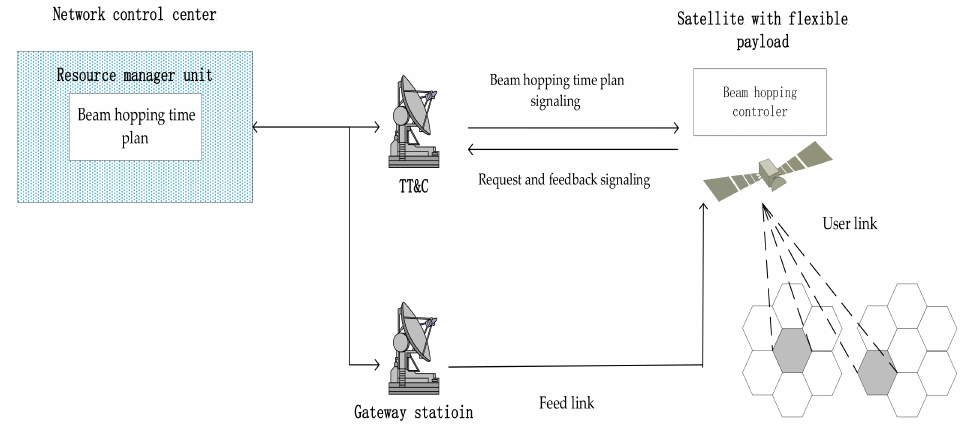
Figure 1. Beam hopping system.